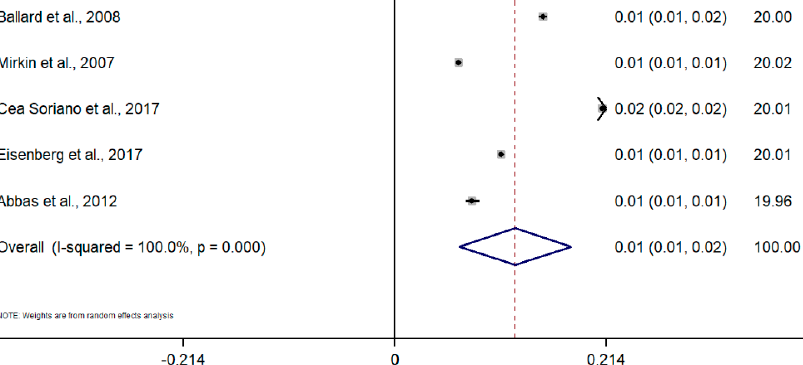
Figure 3. Meta-analysis of the prevalence of endometriosis based on population-based integrated information systems. Note: black lines with squared dots—the prevalence with confidence intervals for each individual study; rhombus—pooled prevalence with confidence interval; red dotted line— line of no effect (studies crossing the line are not statistically different).